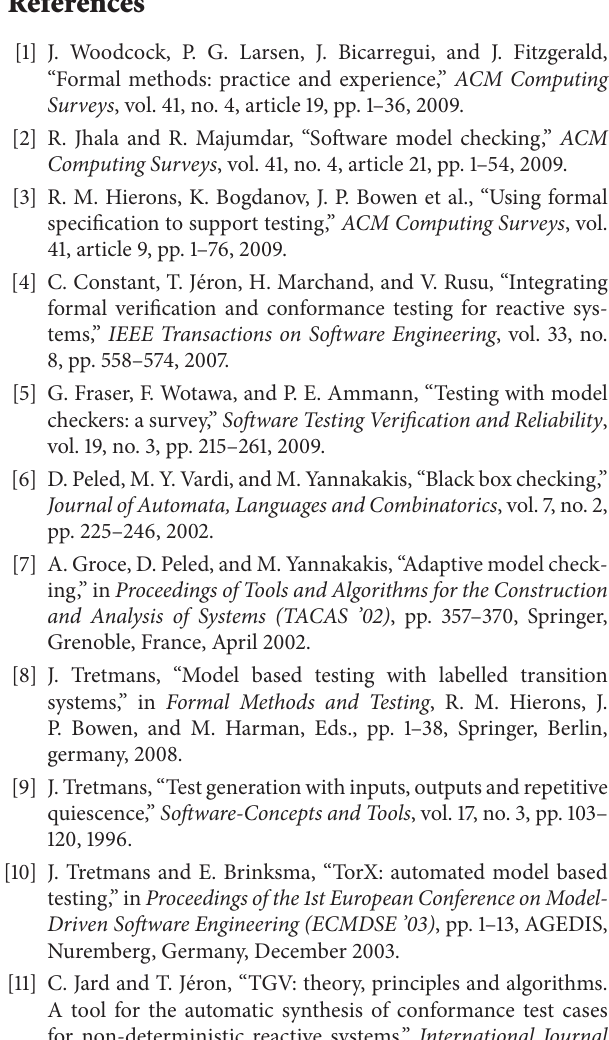
else output error();”, so that the UIE error mentioned above will not